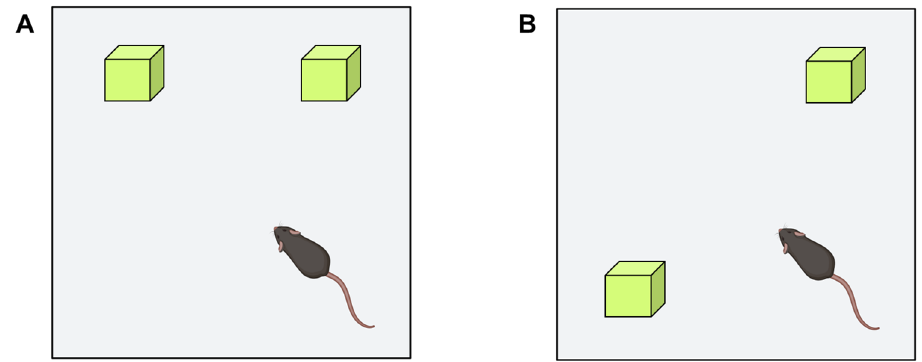
Figure 9. Object location test used to evaluate the spatial memory. During the habituation phase ( A ), mice are invited to explore the two objects located in the open field. After a resting period, mice are re-exposed to the same arena by changing the position of one of the objects ( B ) and measuring the exploration time of each one.